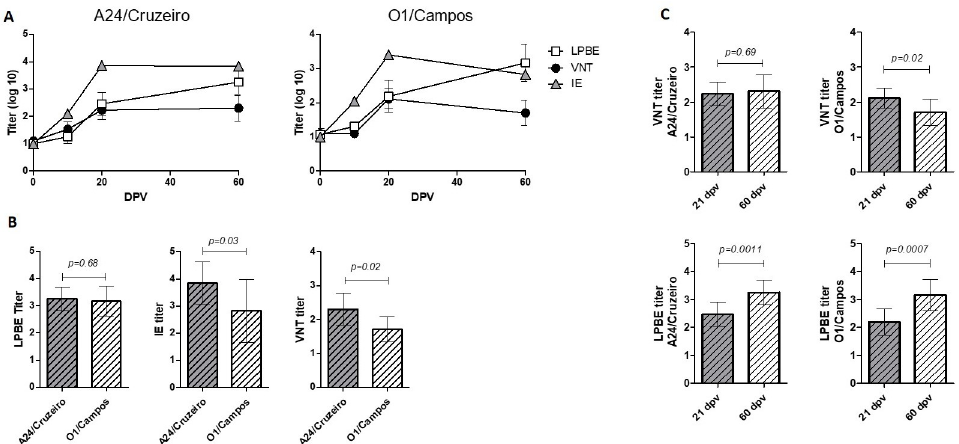
Fig 3. Total and neutralizing antibodies. (A) Kinetics of neutralizing antibodies (VNT) and total antibody titers measured with liquid-phase blocking ELISA (LPBE) or indirect ELISA (IE) as indicated. Mean titers ± SD are depicted. (B) Comparison of LPBE, IE and VNT titers at 60 dpv against A24/Cruzeiro and O1/Campos strains. (C) Pairwise comparative analysis of neutralizing and total antibody levels (estimated using LPBE) at 21 vs 60 dpv, for both strains. Statistically significant differences between groups are